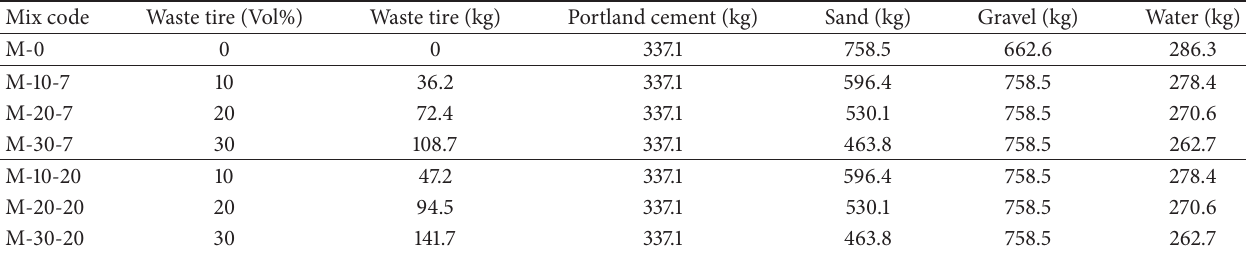
Table 1: Components of the concrete for producing 1m 3